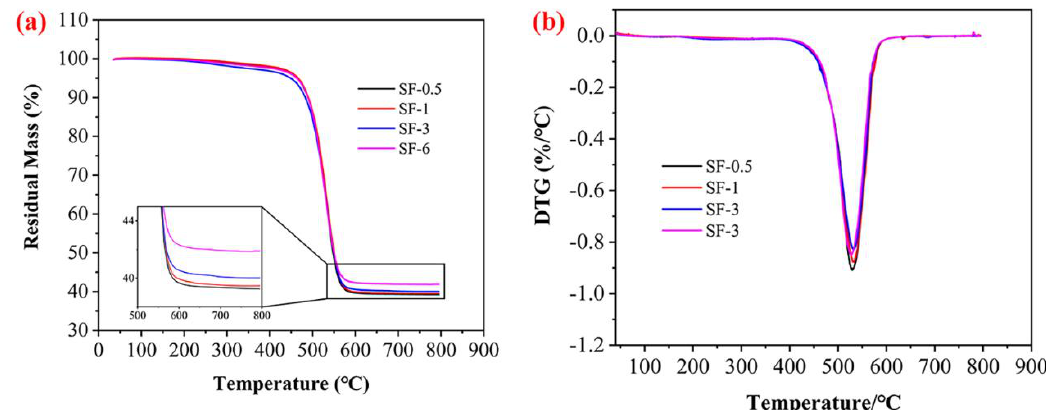
Table 2. Mechanical and physical properties of the composites.